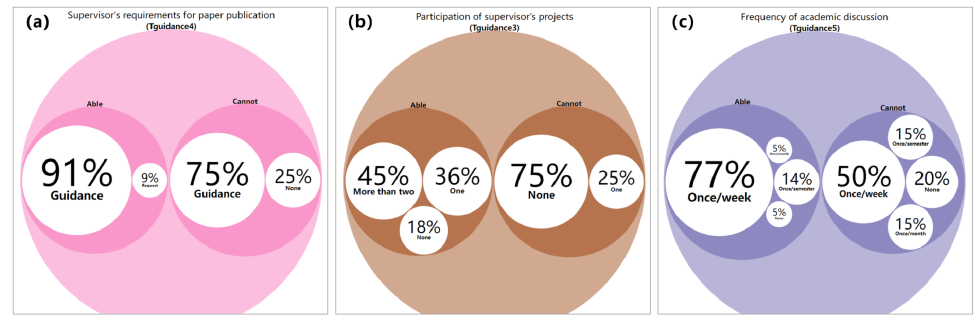
Figure 7. Predicted results of whether first-year graduate students will be able to publish papers. ( a – c ) show the results for typical factors in grades A, C and D, respectively, i.e., Supervisor’s